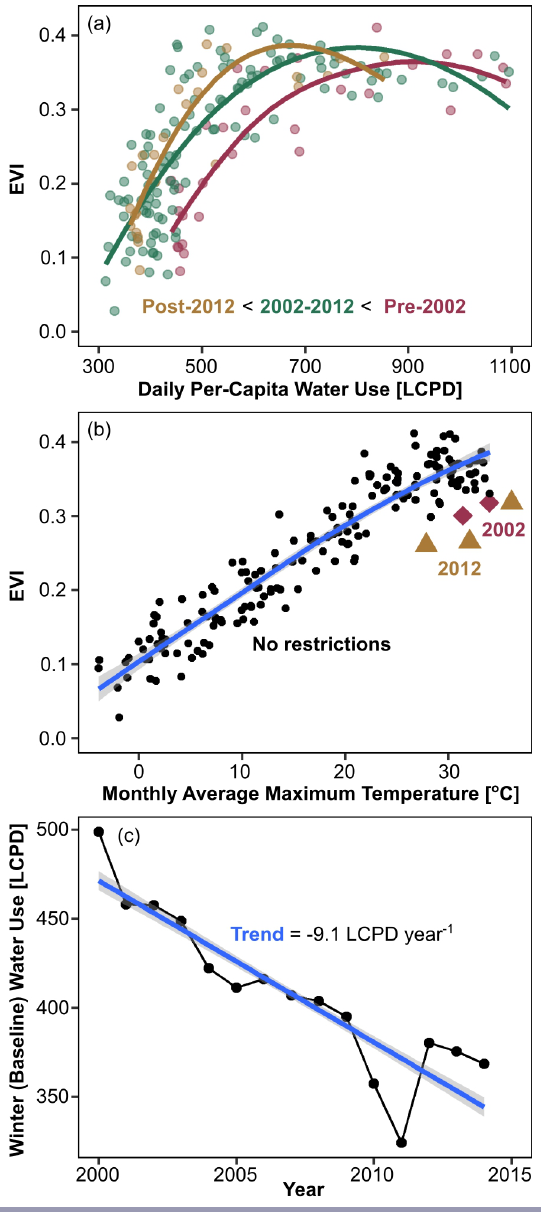
Fig. 4 . (a) Enhanced Vegetation Index (EVI) as a function of per-capita daily water use. (b) EVI as a function of monthly maximum temperature. Summer values during mandatory water restrictions are highlighted in orange (2002) and brown (2012) and fall significantly below a loess curve fit to data during periods of voluntary or no restrictions. (c) Winter urban water use data demonstrates ongoing passive conservation, at a rate of ~2%